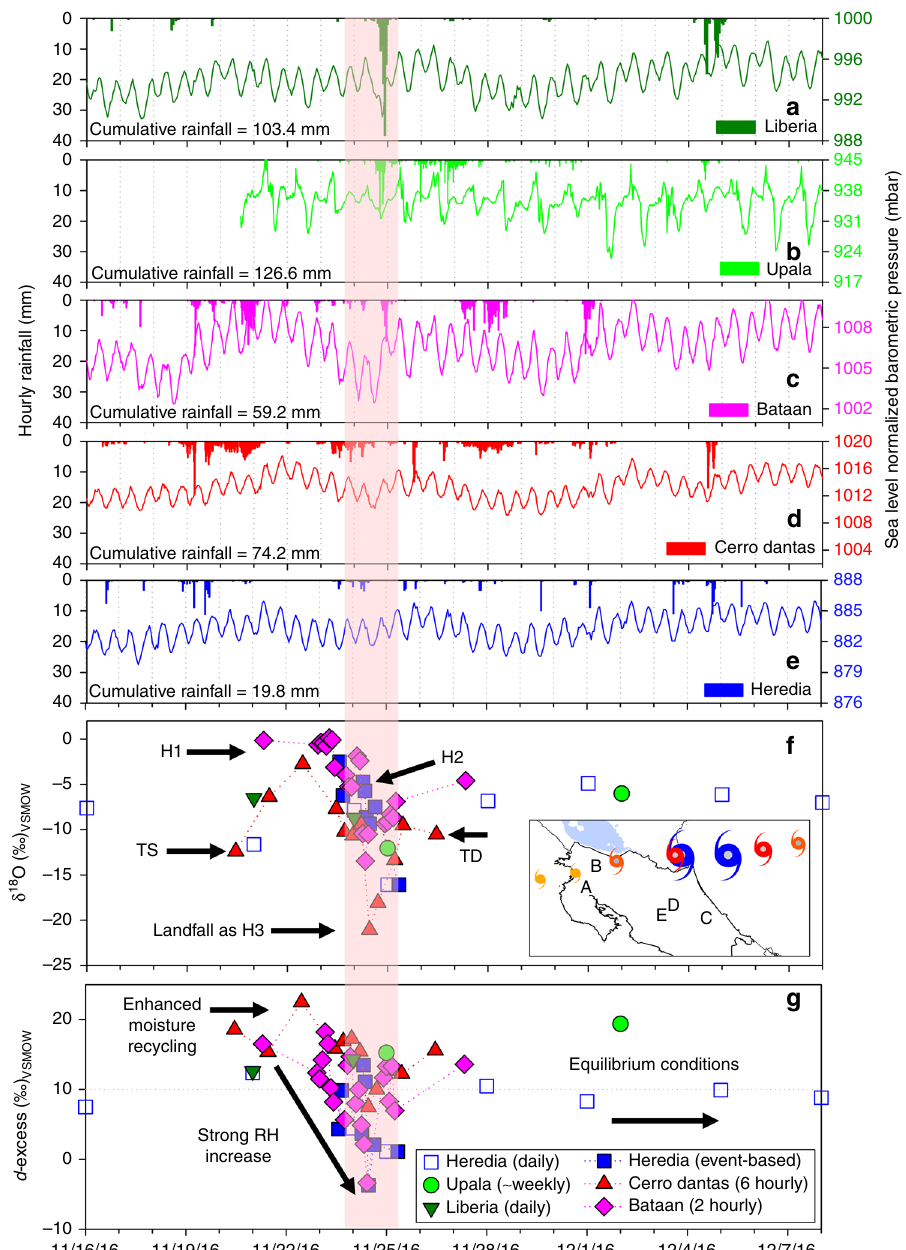
Fig. 5 Isotopic and meteorological co-evolution of Hurricane Otto at fi ve selected locations (color-coded) across the Paci fi c and Caribbean slopes of Costa Rica. a – e Hourly rainfall (mm) and sea level normalized barometric pressure (mbar). Cumulative rainfall values correspond to November 24 – 25, 2016. f , g Present the δ 18 O ( ‰ ) and d -excess ( ‰ ) variability prior to, during, and after Hurricane Otto passage across the Costa Rica-Nicaragua border at event-based, 2-hourly, 6-hourly, daily, and weekly sampling frequencies, respectively. Map inset in f shows the location of the selected sites relative to